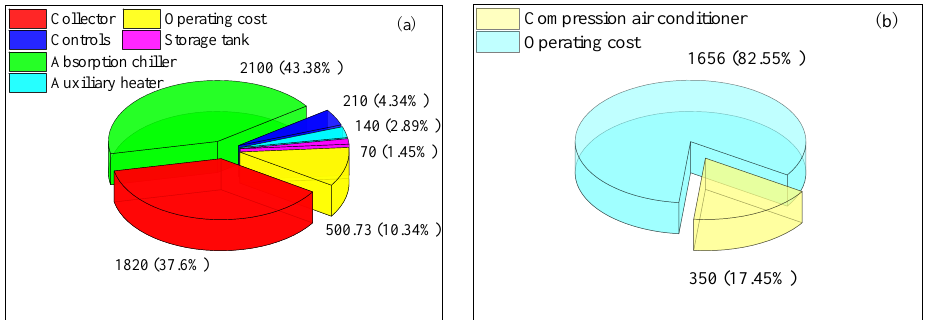
Figure 11. Levelized cost of solar refrigeration system and compression refrigeration system ( a ) solar refrigeration system ( b ) compression refrigeration system.